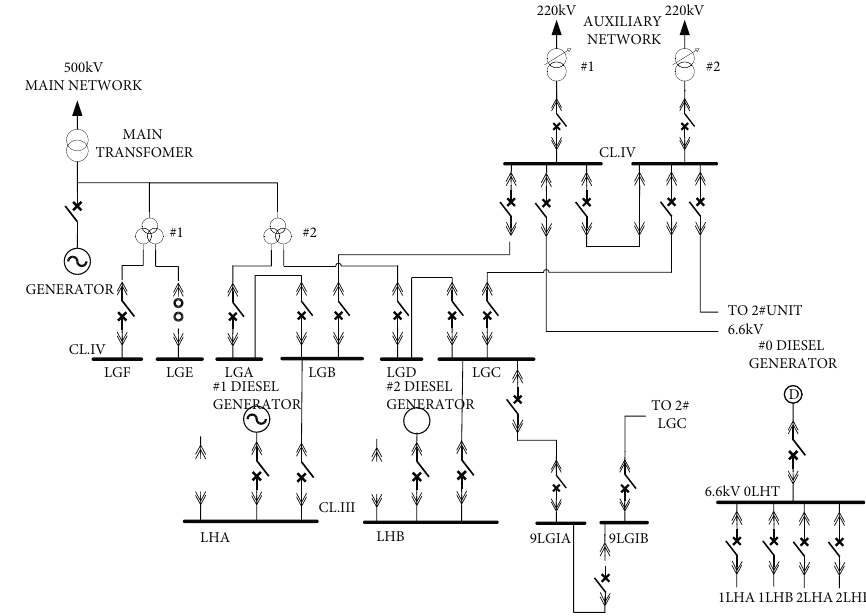
Figure 1: Schematic diagram of circuit of the M310 nuclear power